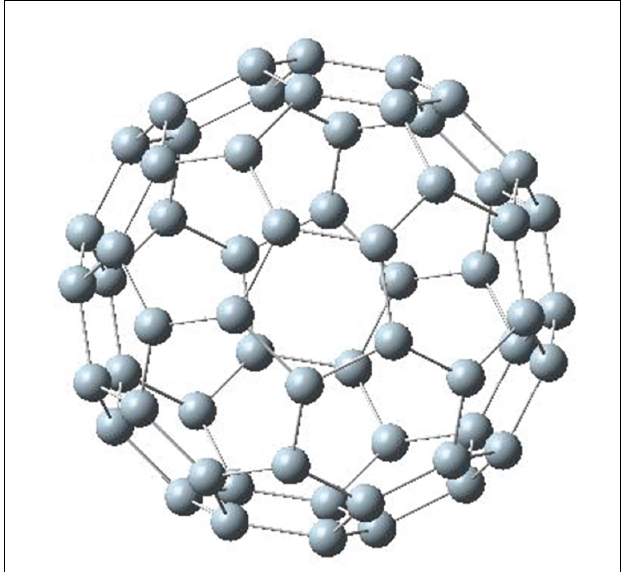
FIGURE 1 | Si 60 fullerene relaxed with symmetry constraint. This structure was used as a template to construct the other Si 30 C 30